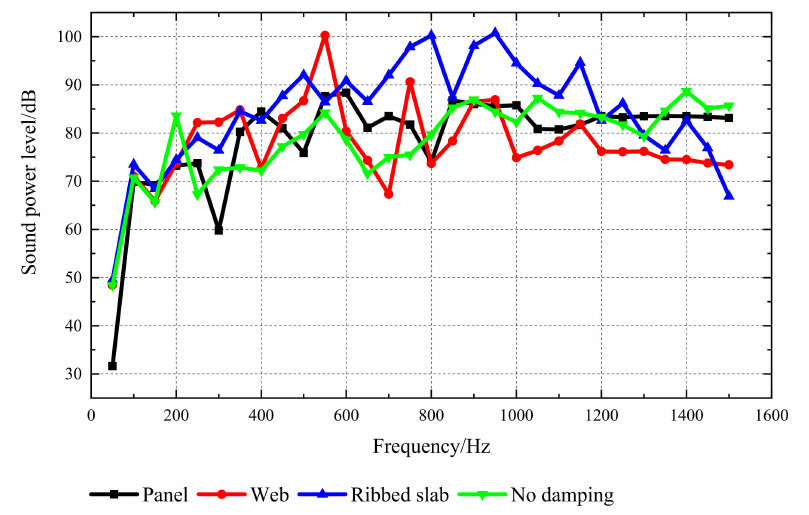
Figure 12. Sound power level corresponding to different damping